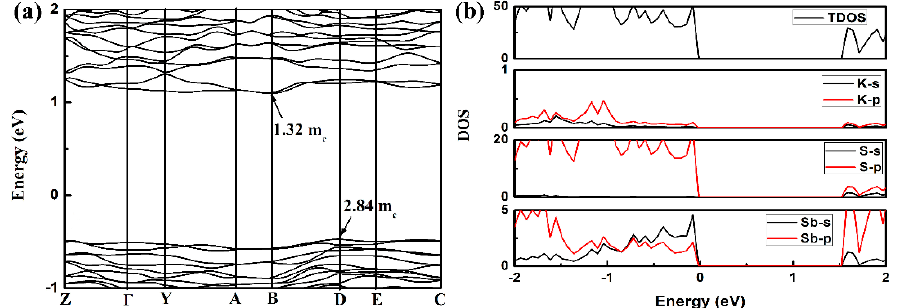
Figure 7. ( a ) Band structure of KSb 5 S 8 with effective mass at valence band maximum (VBM) and conduction band minimum (CBM). ( b ) Total and partial density of states of KSb 5 S 8 .